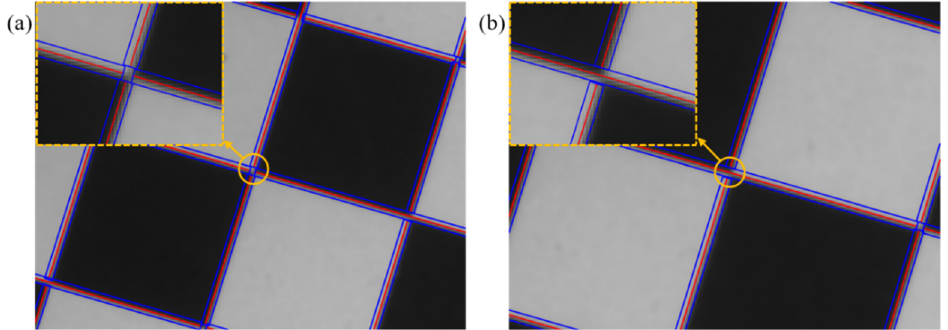
Figure 3. Delineation result of rectangular area around the fracture straight line: ( a ) rectangular area around the four straight lines, ( b ) rectangular area around the three straight lines.